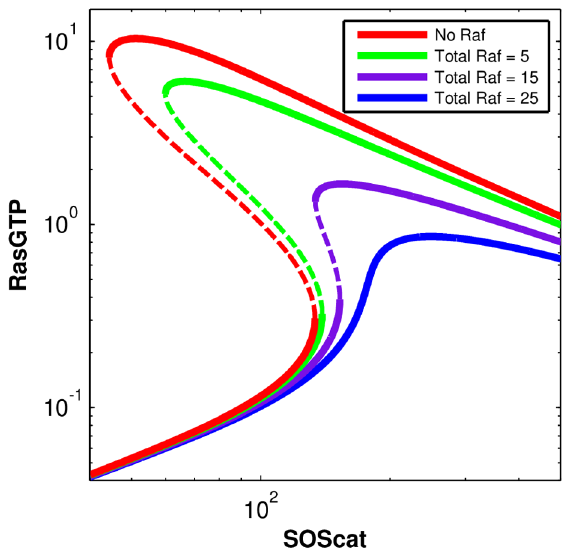
Figure 9. Bifurcation diagram of the Ras switch with different levels of Raf (load) on the system. The total number of SOS in the simulation box is used as the parameter being tuned, which varies from 0 to 1000. For Raf=0, Raf=10 and Raf=30, there are two bifurcations as SOS is increased. In the first bifurcation a new high valued stable steady state appears along with the low valued stable steady state. In the second bifurcation, the low valued stable state disappears leaving behind only the high valued state. The dotted line marks the unstable steady state that also comes into existence in the bistable region. As total Raf increases, the two bifurcations approach each other. When Raf=50, the system has lost both of its bifurcations and is characterized by a single stable steady state at all values of